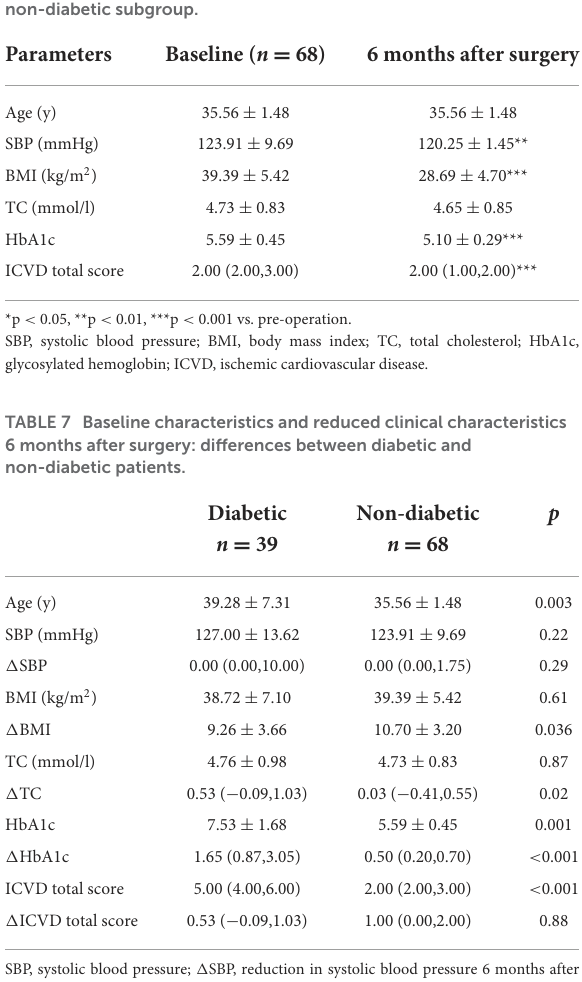
TABLE 4 Baseline characteristics and reduced clinical characteristics 6 months after surgery: differences between the sexes.